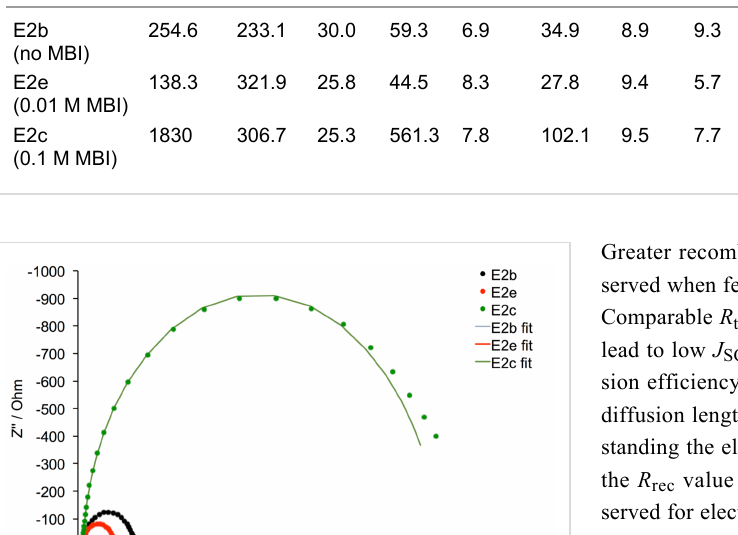
Table 5: EIS data obtained from measurements at a light intensity of 22 mW cm − 2 of n-type DSCs containing FTO/TiO 2 working electrodes, dye 1 and either electrolytes E2b, E2e or E2c (see Table 3 for compositions). Experimental values of J SC , V OC and η from Table 4 are included for convenience. Electrolyte